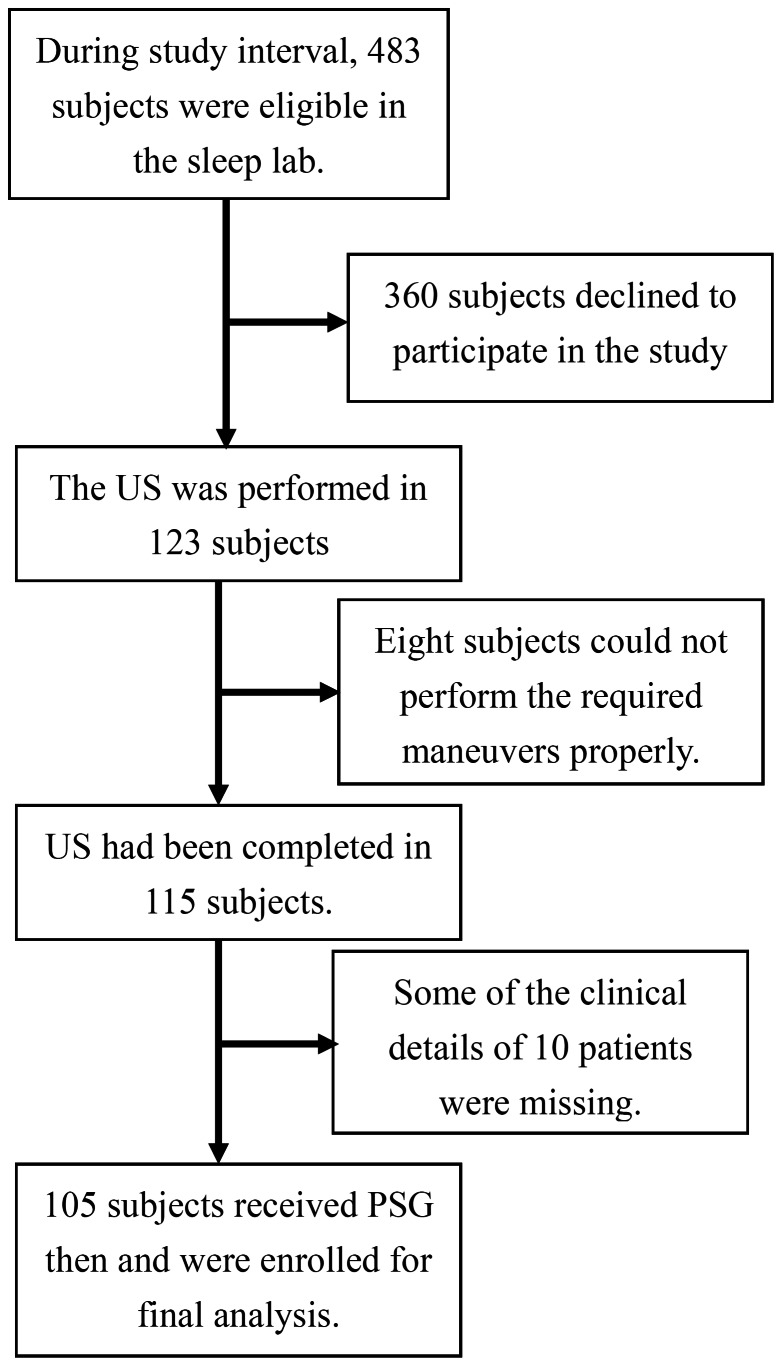
Flowchart of the trial.